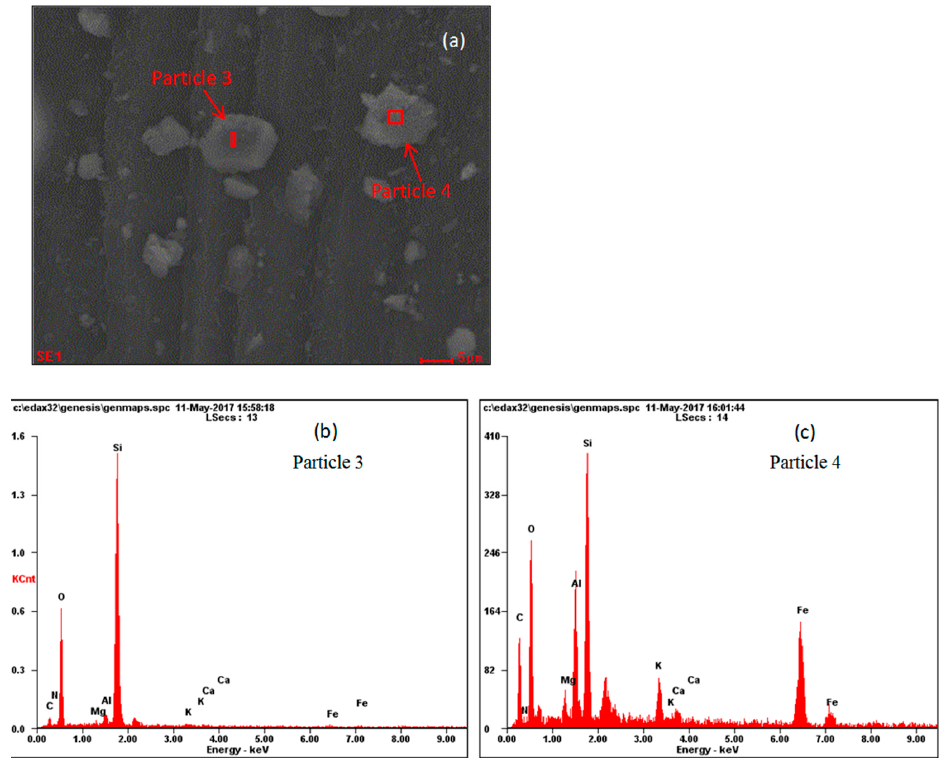
Figure 15. SEM micrographs of Pinus tabulaeformis leaves after dust storm ( a ), and EDS pictures of two PM 10 particles ( b , c ) ( × 8